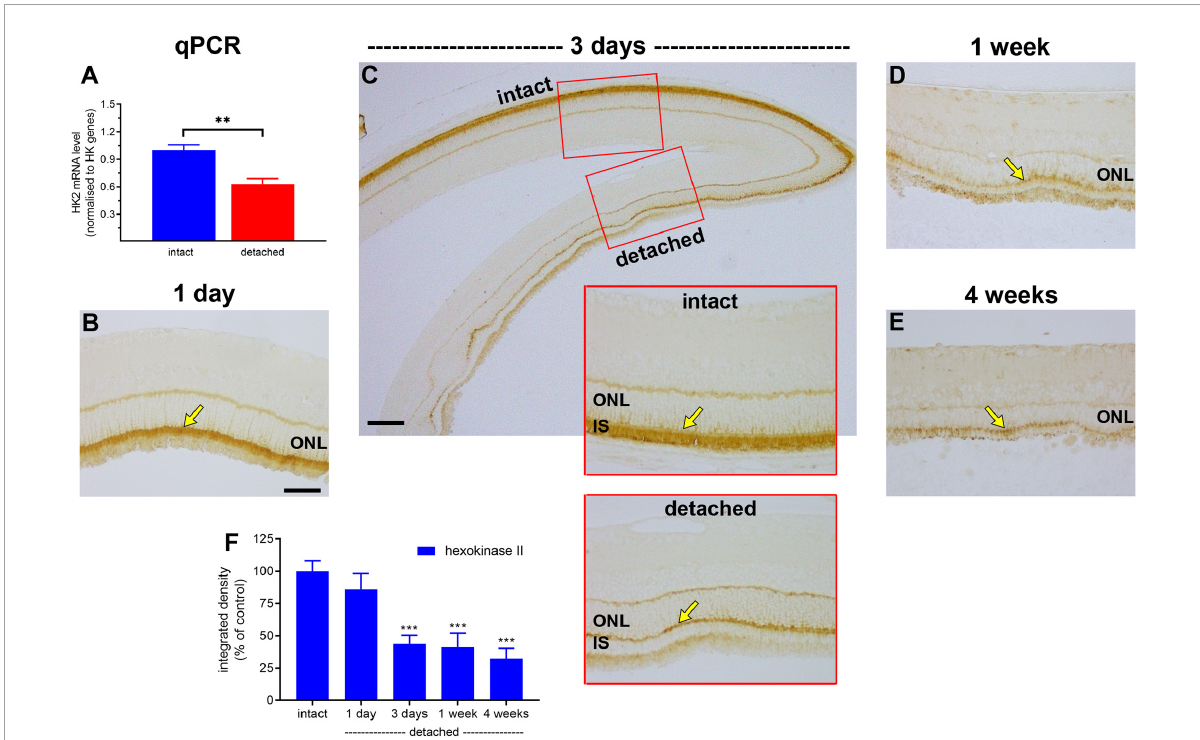
FIGURE4 Effect of retinal detachment on expression of hexokinase II, as evaluated by qPCR and immunohistochemistry. (A) Quantification of HK2 mRNA level at 1 day after detachment. Values (mean ± SEM) are normalised to a pool of two housekeeping genes and expressed as % of the intact group. ** P < 0.01 by Student’s unpaired t -test. (B–E) Representative images of hexokinase II immunolabelling in intact retina, and at 1 day, 3 days, 1 week, and 4 weeks after detachment. Arrows highlight photoreceptor inner segments. (F) Quantification of hexokinase II immunoreactivity associated with inner segments (IS) at 1 day, 3 days, 1 week, and 4 weeks after retinal detachment. Values, shown as % of the intact group, represent mean ± SEM. *** P < 0.001 by Student’s unpaired t -test followed by modified Bonferroni correction (intact vs. detached). Scale bars: (A–C) (insets), (D) = 60 µ m; (C) (overview) = 150 µ m. ONL, outer nuclear